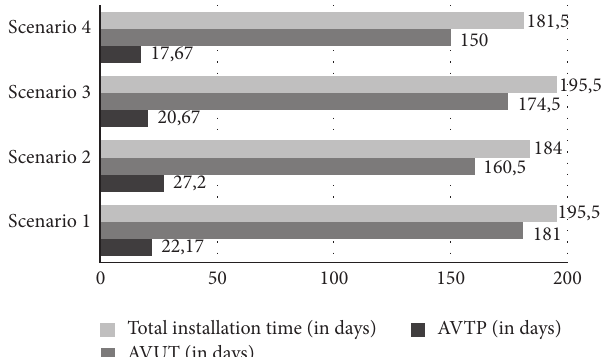
Figure 3: Performance measures of four information sharing scenarios.